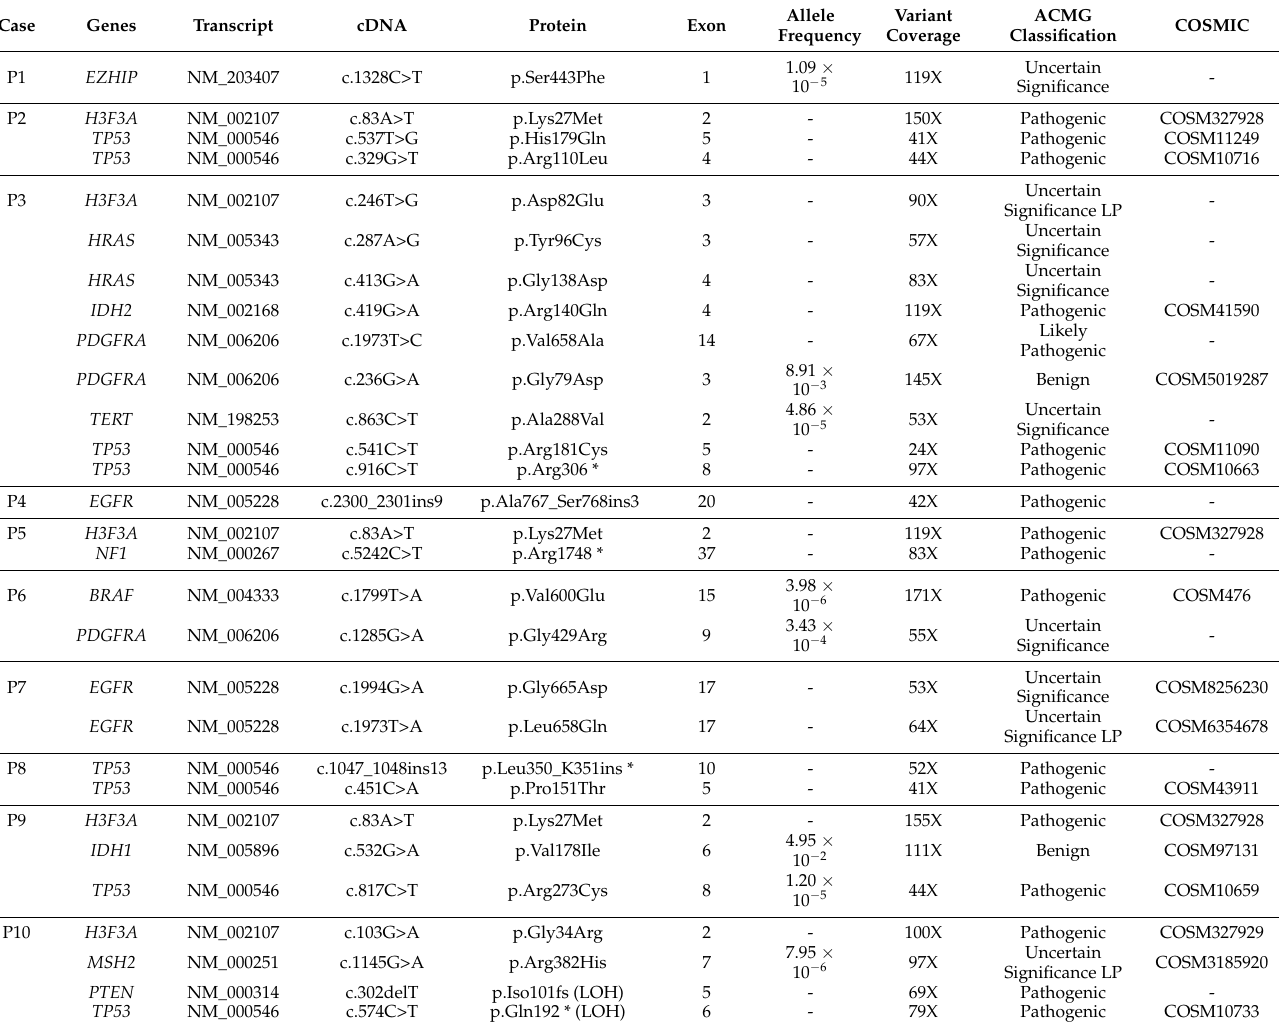
Table 2. Variants identified by gene panel analysis. Uncertain Significance LP: VUS with minor pathogenic evidence; LOH: Loss of Heterozygosity; allele frequency from gnomAD (https://gnomad. broadinstitute.org/, 28 February 2022 NFE-population; *: HGVS (https://varnomen.hgvs.org/, 14 June 2021) stop